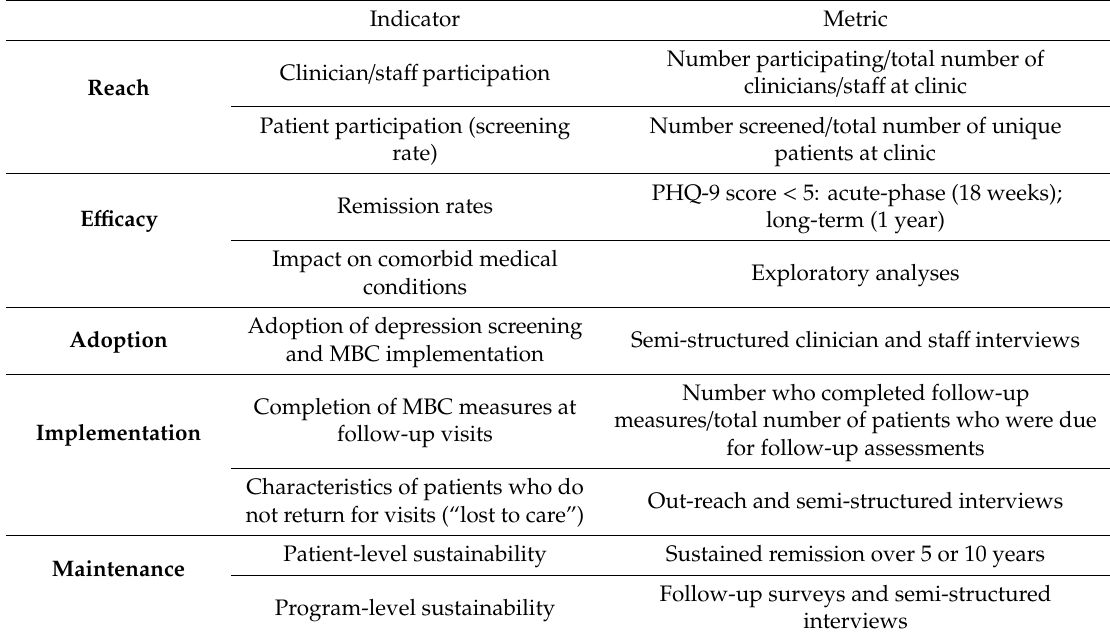
Table 2. The operationalization of RE-AIM framework to measure success of the VitalSign 6